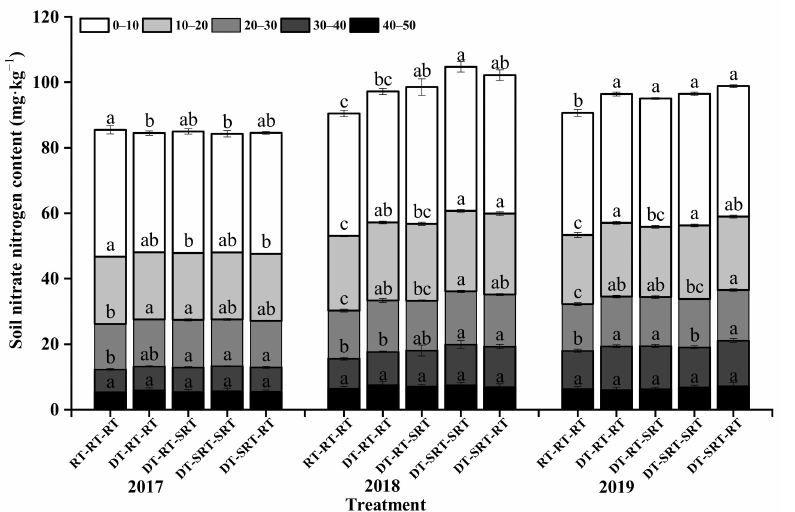
Figure 3. Soil nitrate nitrogen content in different soil layers under different treatments. Note: Different lowercase letters indicate significant differences between different treatments at the same soil layer ( p ≤